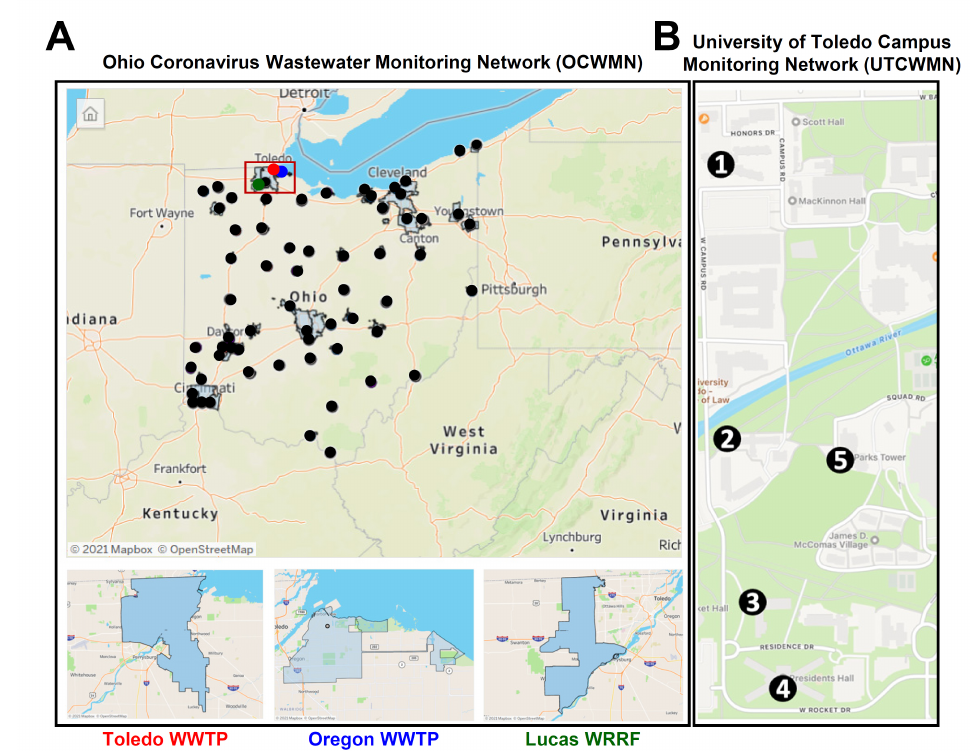
Figure 1. The geographical locations of the sample collection points. ( A ) A map of the Ohio Coron- avirus Wastewater Monitoring Network (OCWMN), highlighting the sample collection points from the various WWTPs (top panel). The inset indicates the TOLWMN collection points. The WWTPs from the Toledo area used for the analyses by the OCWMN (bottom panel). ( B ) The UToledo campus map highlights the locations of the sample collection sites (1–5) in the